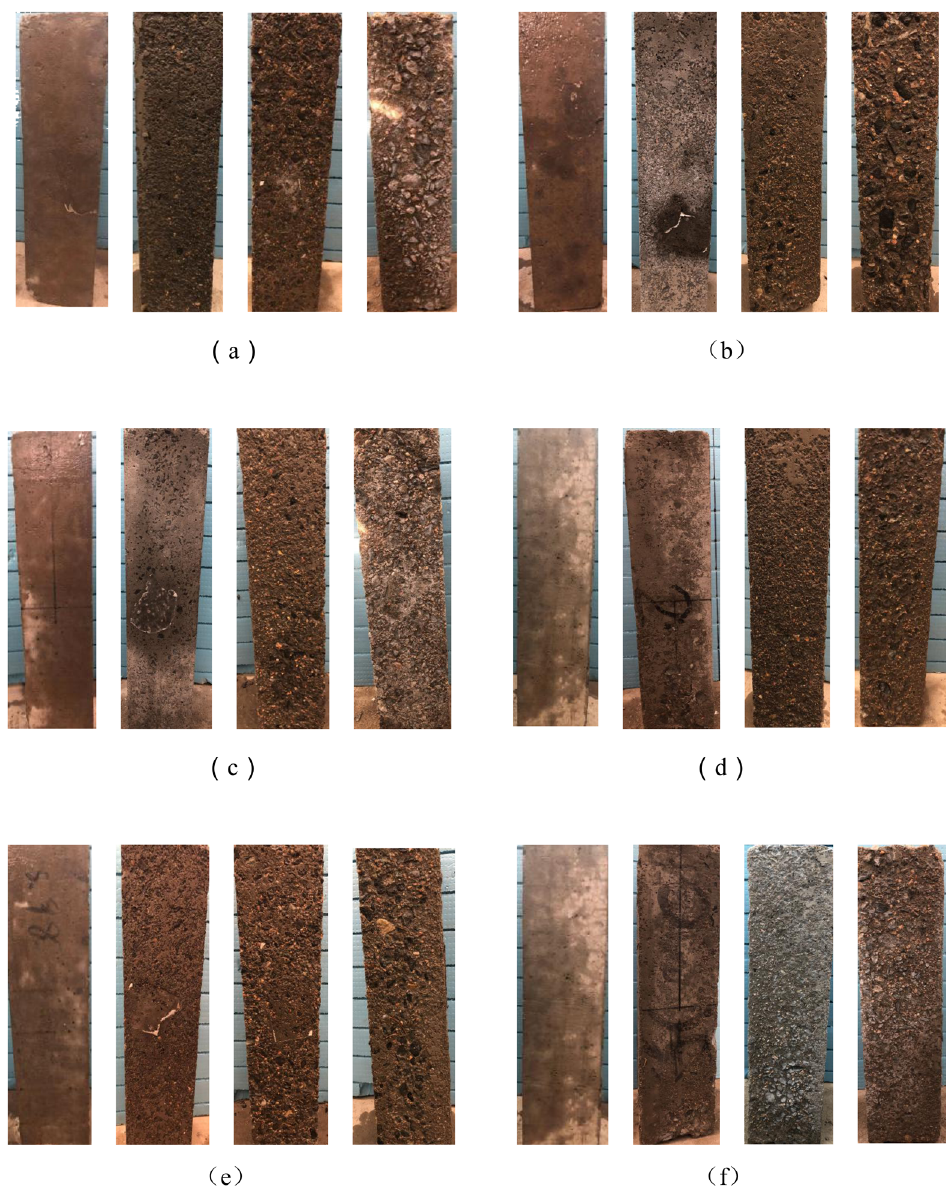
Figure 4: Failure characteristics. ( a ) C, ( b ) SSC 20 – 20 , ( c ) SSC 20 – 40 , ( d ) SSC 20 – 60 , ( e ) SSC 40 – 20 , and ( f ) SSC 60 – 20